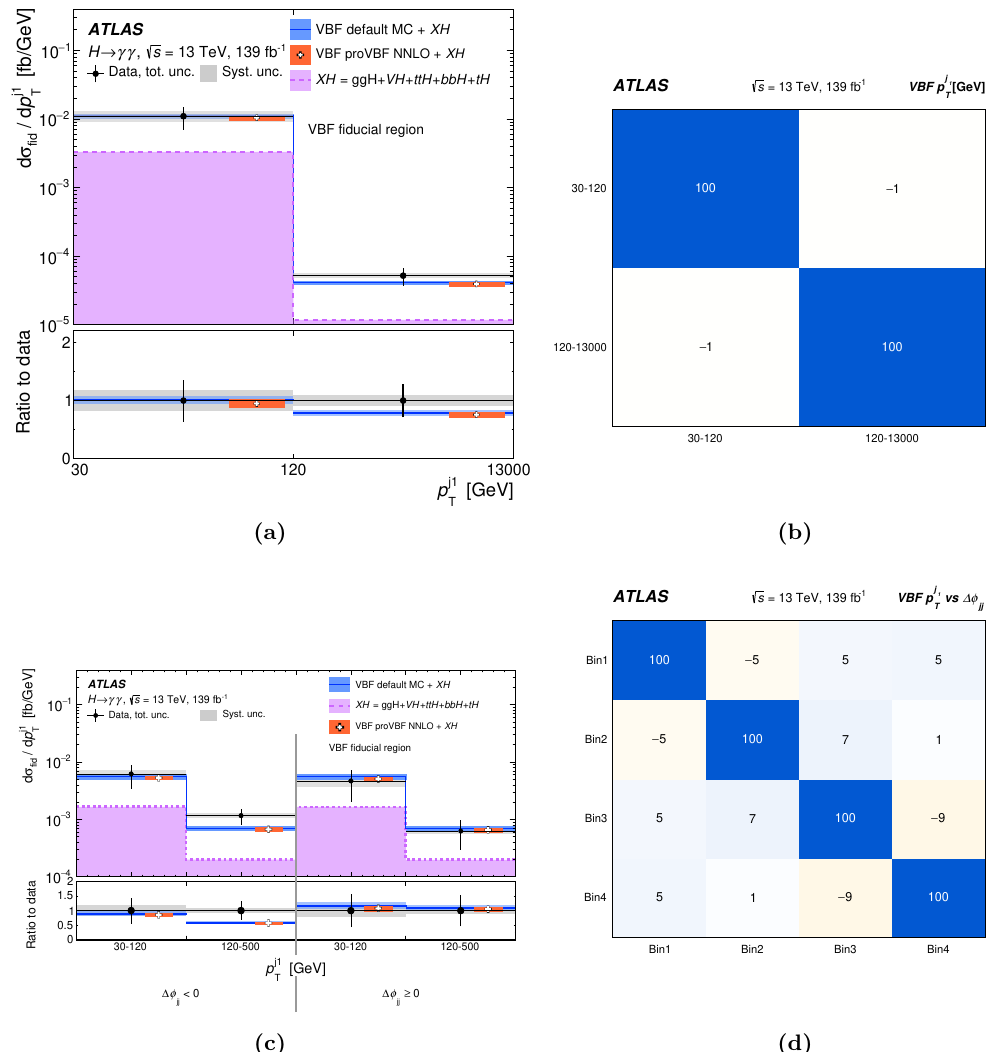
Figure 36. Particle-level fiducial differential cross-section times branching ratio for the variable (a) p j 1 together with the corresponding correlation matrix in the VBF-enhanced fiducial region (b). T Double-differential particle-level fiducial cross-sections times branching ratio of (c) p j 1 together with the (d) corresponding correlation matrices in the VBF-enhanced fiducial region. The order of the bins in the correlation plot is the same as in the plot with the values of the